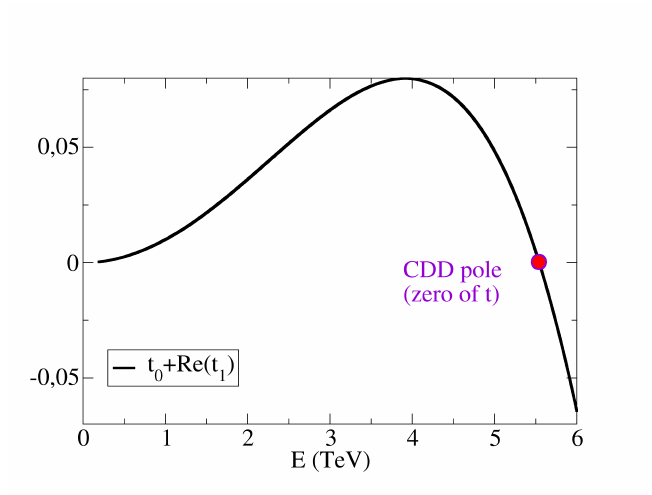
Figure 8: A simple ρ -like resonance in ωω (cid:39) W tion.